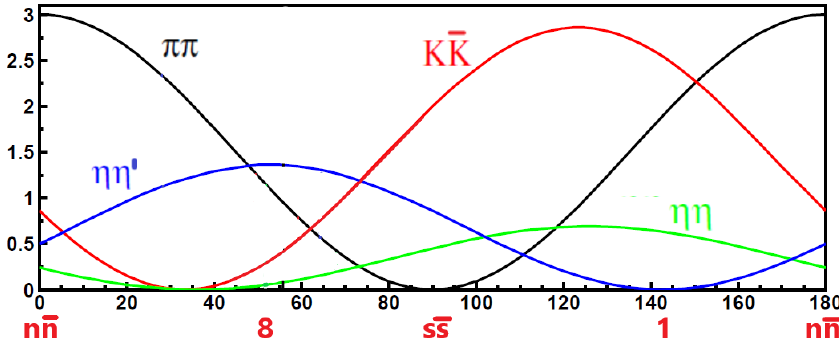
Figure 4: The SU(3) structure constants as functions of the mixing angle α = ϕ − 90 ◦ . For α = 0, the meson is a n ¯ n , for α = 90 ◦ , it is a s ¯ s state. Singlet and octet configu- rations are indicated.